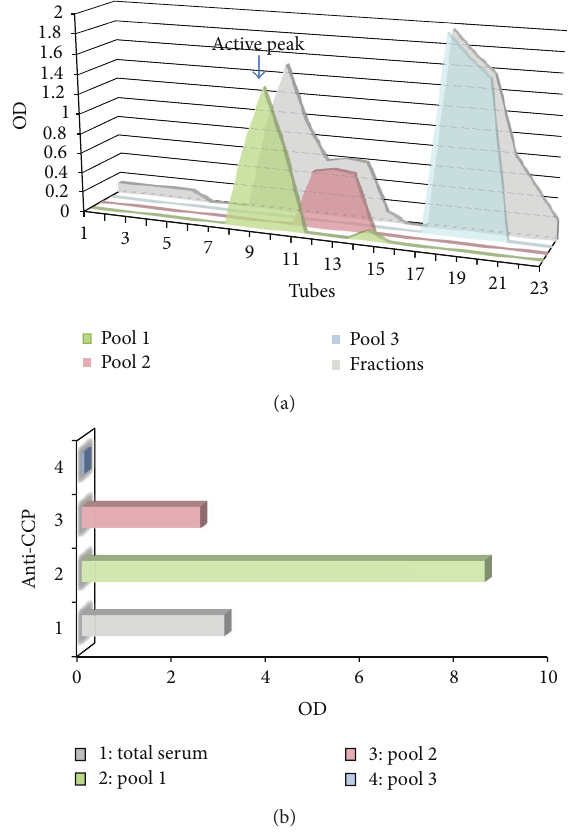
Figure 1: (a) Chromatogram shows the purification of anti-CCP conjugatedantibodythatwasfurtherfractionatedusinggelfiltration chromatography, which produced three fractions. The first pool (tubes9–11)containedtheHRP-anti-CCPconjugates(green)second pool (tubes 12–14) (pink). Pool 3 (tubes 18–20) contained the nonconjugated peroxidase fraction (blue). (b) ELISA graph of different fractions obtained by gel filtration. Pool 1 was very reactive for CCP, with an optical density that was threefold higher than the original serum titre. Pool 2 activity was weaker, and pool 3 was negative. (OD: optical